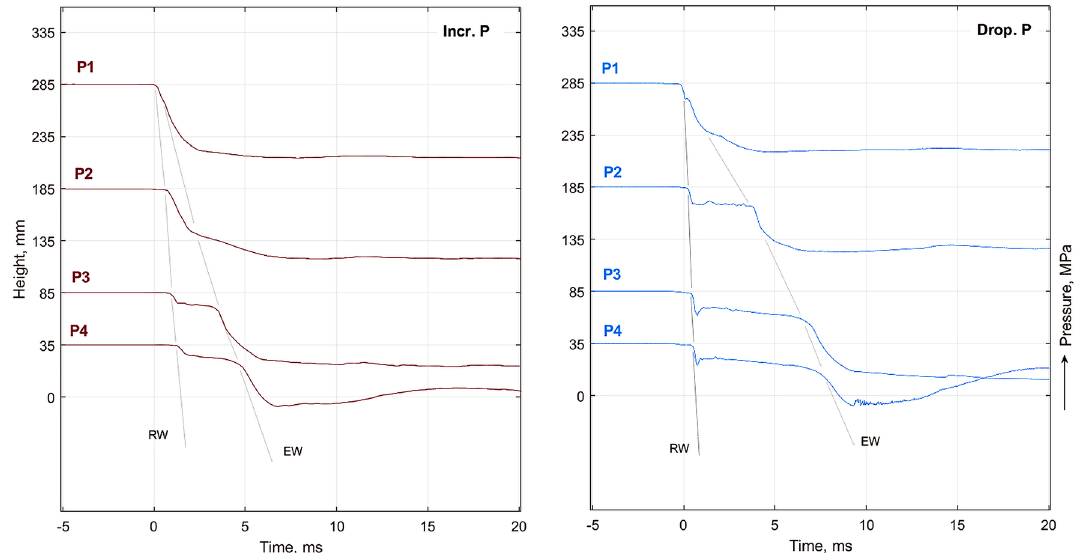
Fig. 6 Diagram vessel height vs. time for pressure readings during 25 ms of liquified CO ing (right) the pressure in the MPS. This shows the wave trajectories of rarefaction (RW) and evaporation